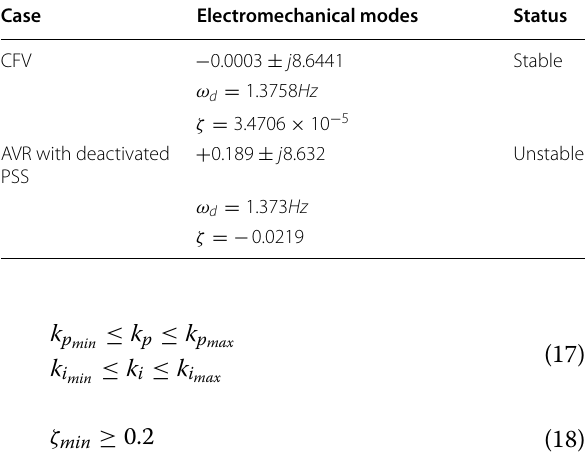
Table 1 Electromechanical